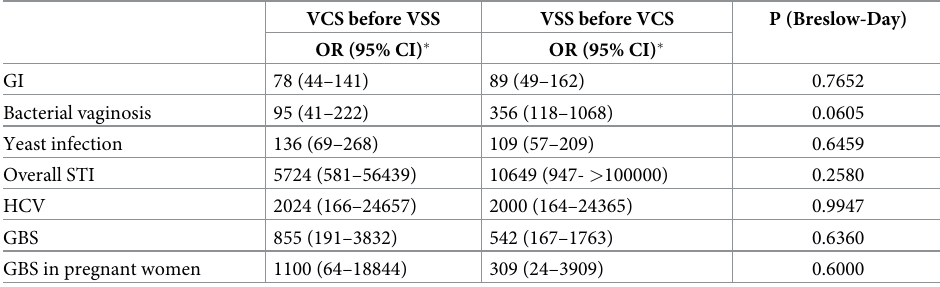
Table 4. Comparison of sampling randomisation sequences among GI agents.